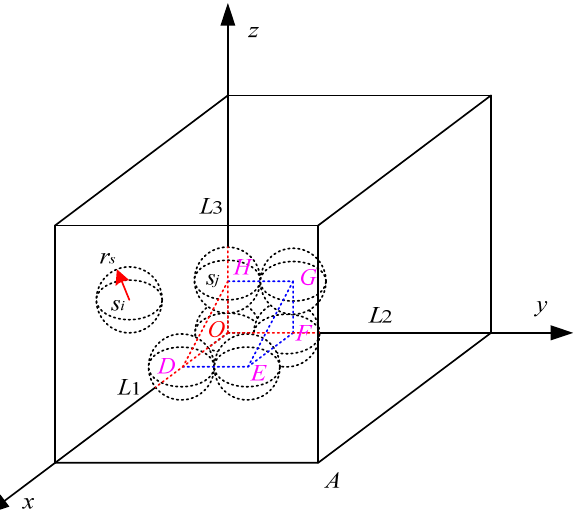
Figure 3. Schematic diagram of 3D node coverage.